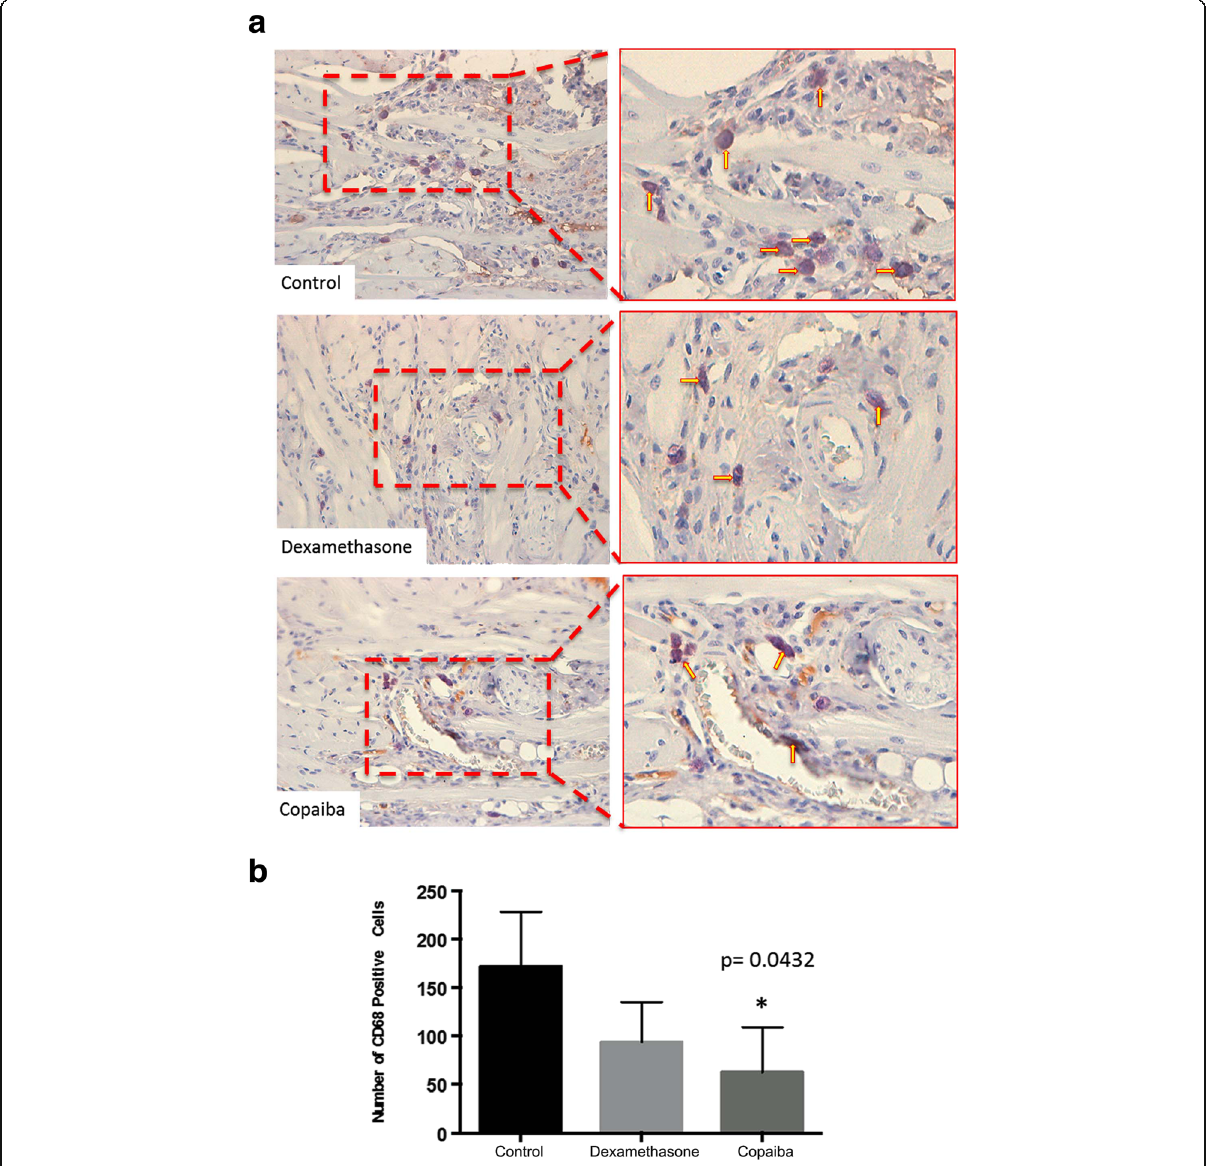
Fig. 4 Effect of treatment with copaiba oil-resin on transfixing lesions in rats ’ tongues comparing the CD68-positive cells. a Photomicrographs showing CD68-positive cells ( arrows ) in control, dexamethasone and oil copaiba Groups. b Graphic illustrating the number of CD68-positive cells in three different treatments ( n = 5 animals per group). * p ≤ .05 compared to control group (one-way ANOVA with Tukey ’ s post-hoc